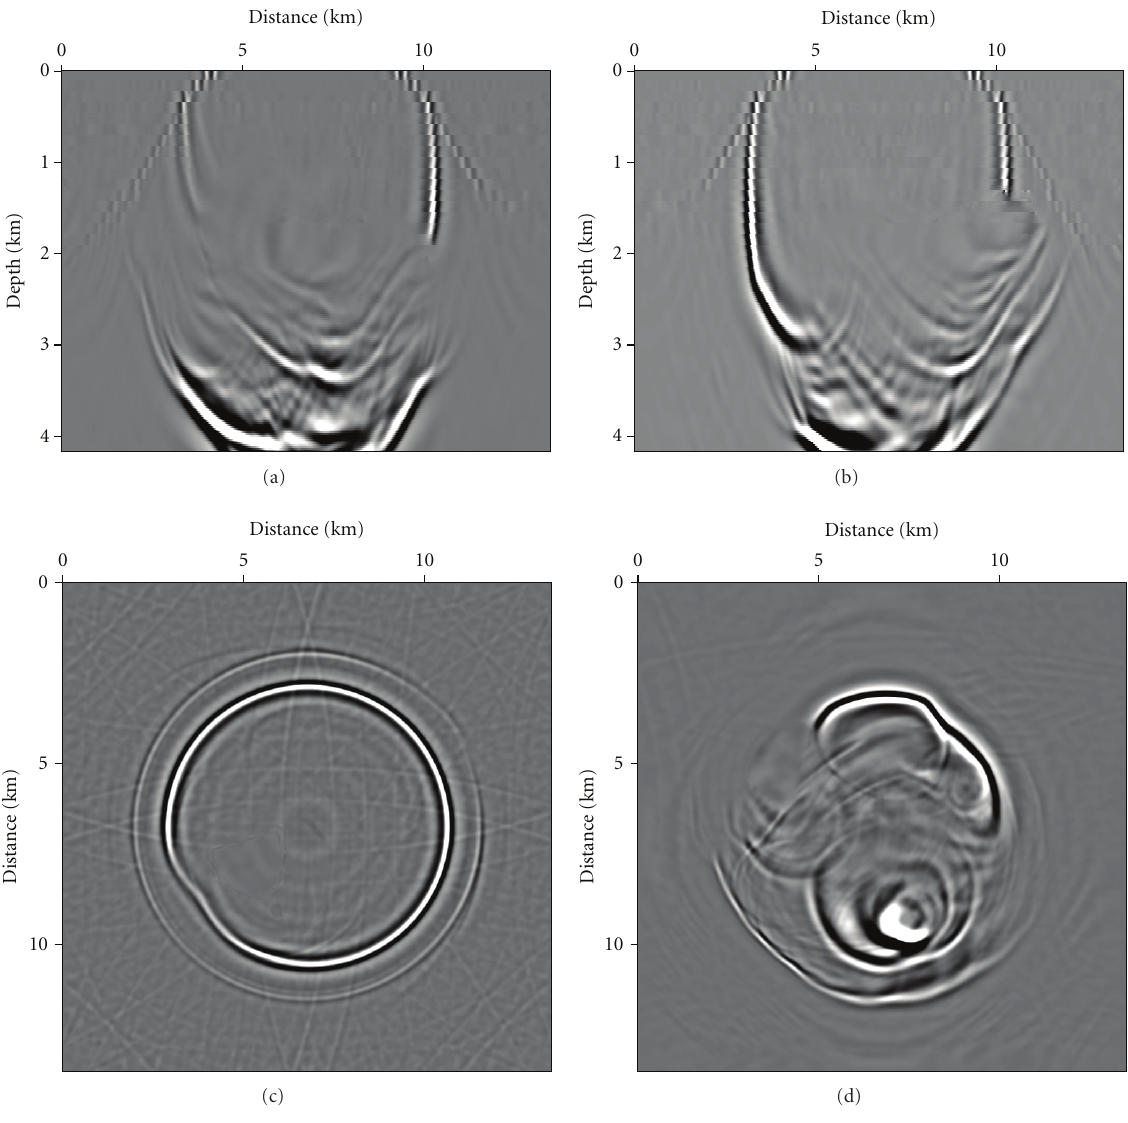
Figure 12: Impulse response obtained by FD migration using alternating four-way splitting and with Li correction (cross-sections as before).